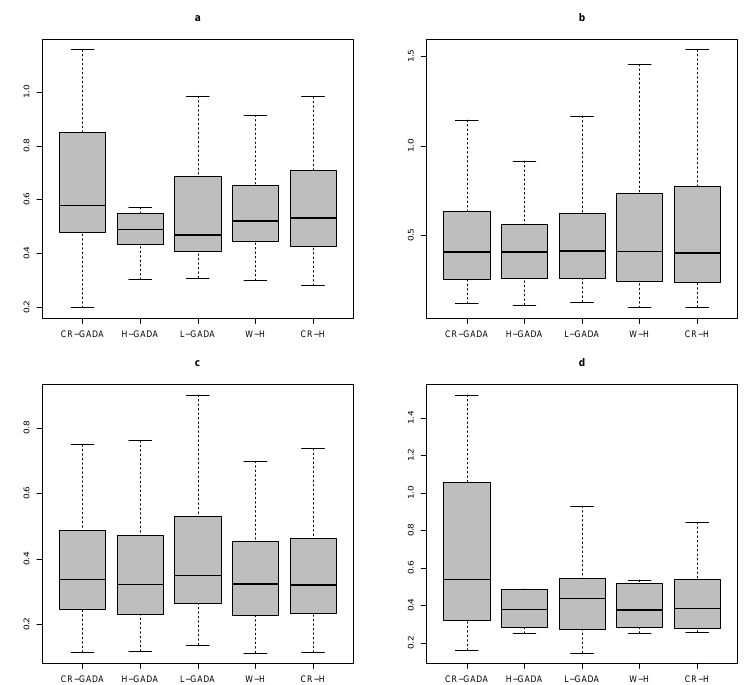
Figure 5. Boxplot (including the minimum score, first (lower) quartile, median, third (upper) quartile, and maximum score) of the Root Mean Square Error (RMSE) function calculated for the species: ( a ) Pinus arizonica , ( b ) Pinus engelmannii , ( c ) Pinus strobiformis and ( d ) Pinus teocote , for the GADA and W-H models in comparison with the CR-H model proposed in the study.